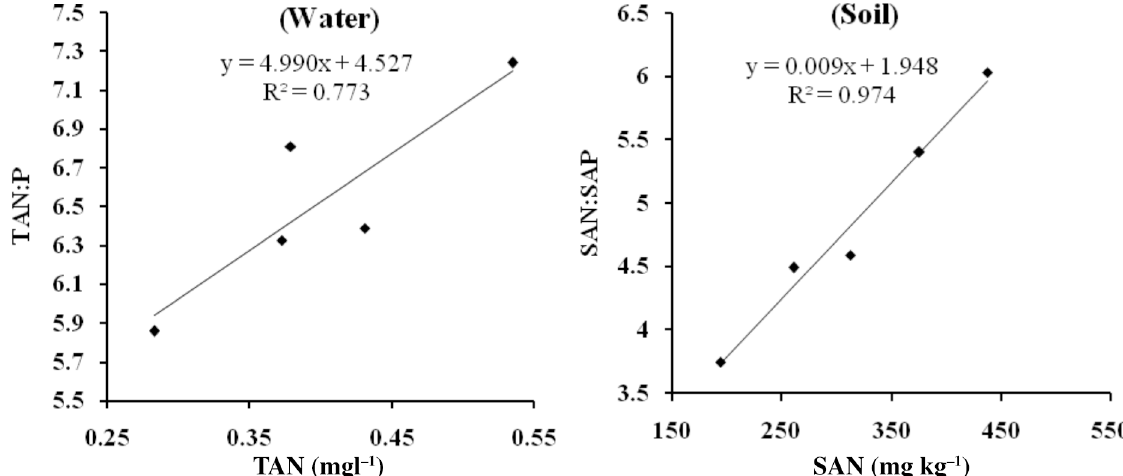
Fig. 9. Linear relationship between TAN vs TAN:P ratio in water and SAN vs SAN:SAP ratio in soil in neem supplemented bio fl oc (E2)